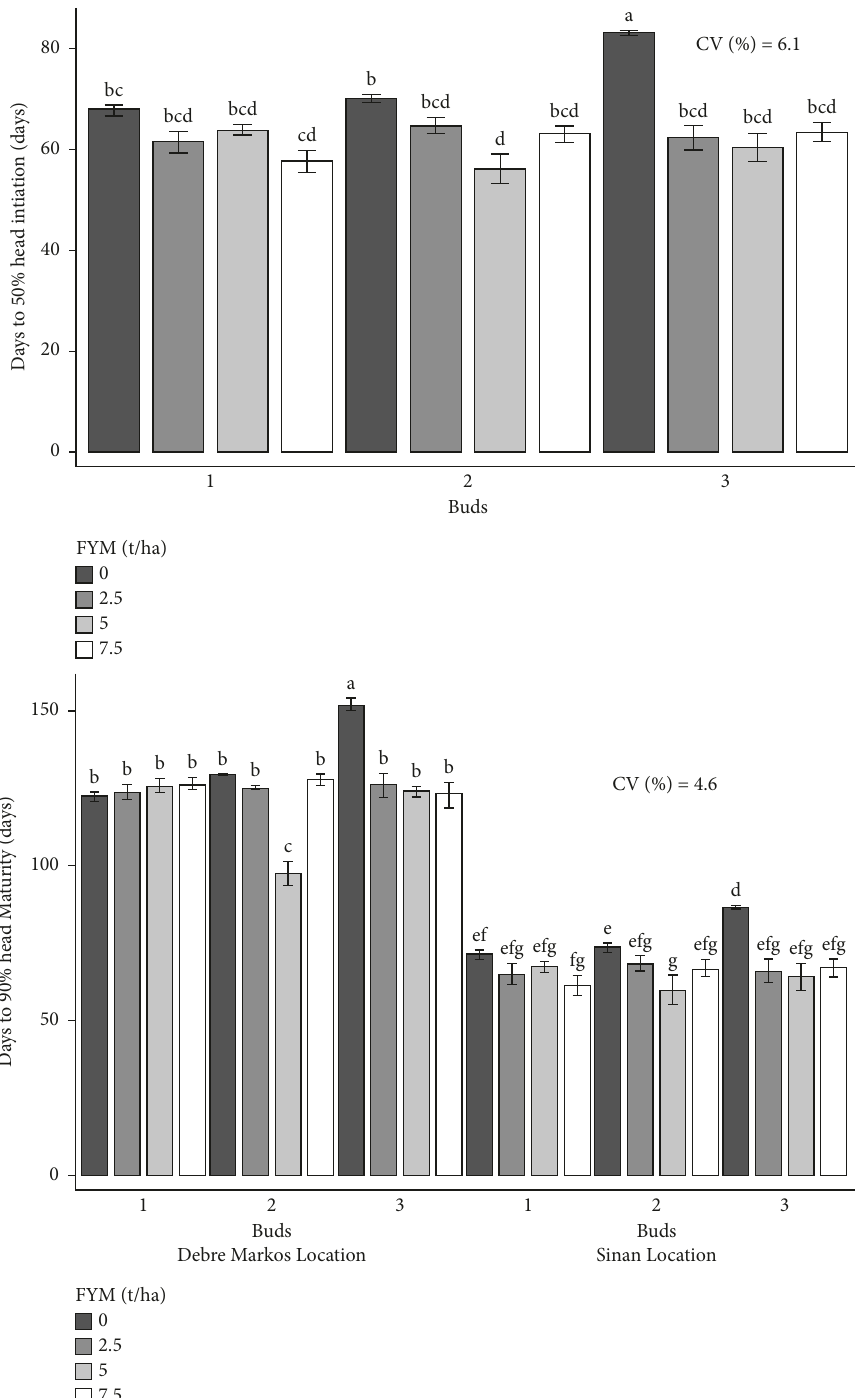
Figure 1: Interaction effects of bud numbers and farmyard manure on cabbage